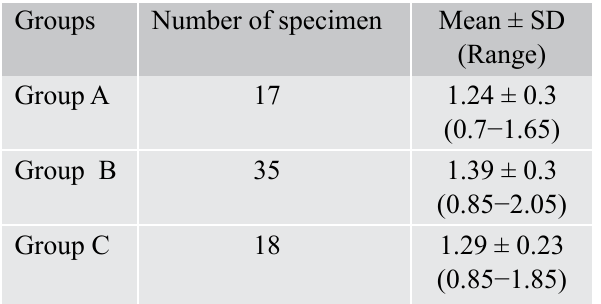
luminal diameter of the trachea was 1.5 ± 0.3 cm in male in Group B and minimum mean (±SD) luminal diameter of the trachea was 1.17 ± 0.26 cm in female in Group C. The mean luminal diameter of the male trachea was found to be greater than that of the female trachea. Mean difference between male and female in Group B was statistically highly significant (P<0.001) but not significant in Group A and C. Table I: Mean luminal diameter of the trachea in different age groups